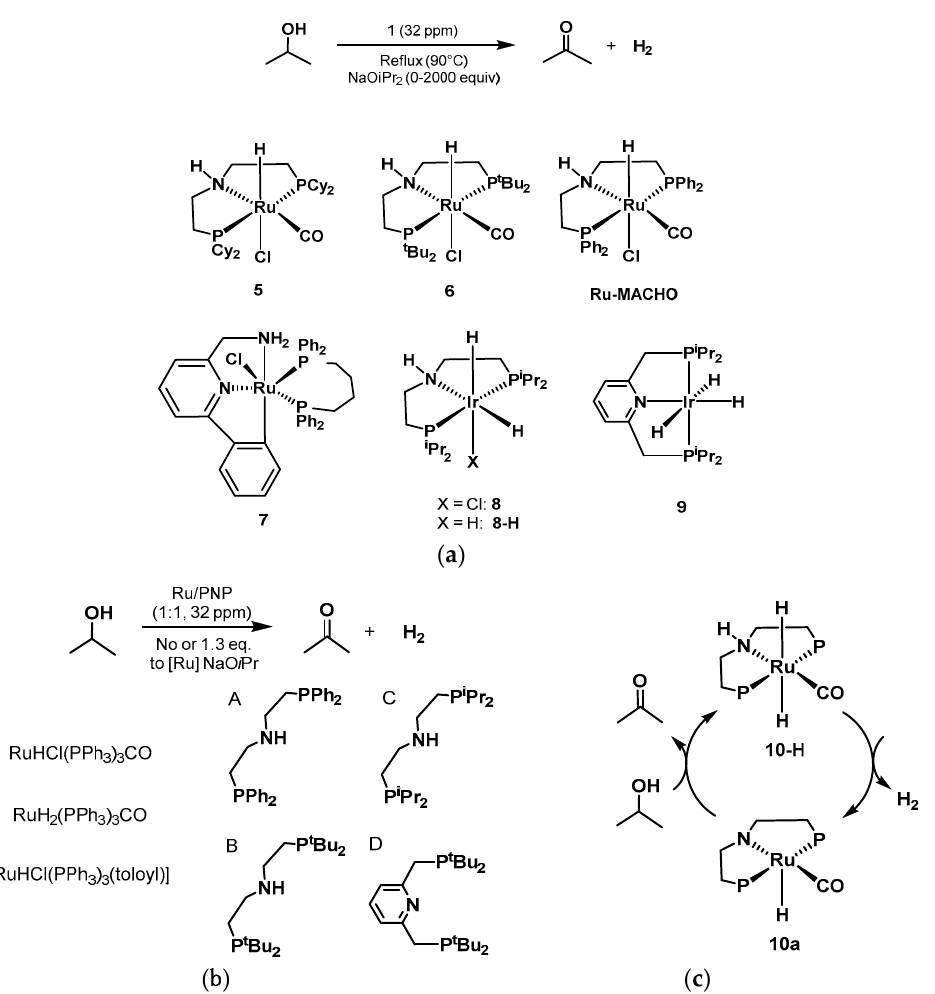
Scheme 2. ( a ) Pincer complexes screened by Beller in 2011; ( b ) low temperature isopropanol dehydrogenation; ( c ) proposed outer-sphere mechanism